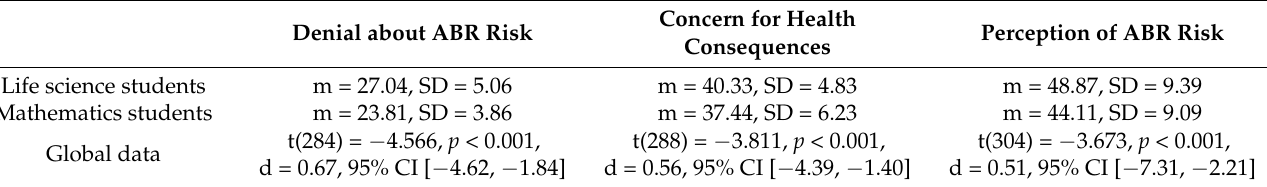
Table 4. Third hypothesis data.